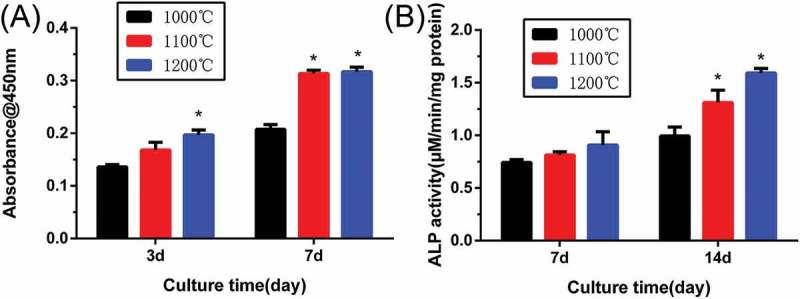
(A) Quantitative analysis of the proliferation of rBMSCs cultured on β-Ca2SiO4 scaffolds for 3 and 7 days (n = 3); (B) ALP activity of rBMSCs cultured for 7 and 14 days on β-Ca2SiO4 scaffolds for 7 and 14 days (n = 3). (* indicates significant differences when compared to β-Ca2SiO4 scaffolds sintered at 1000 °C).